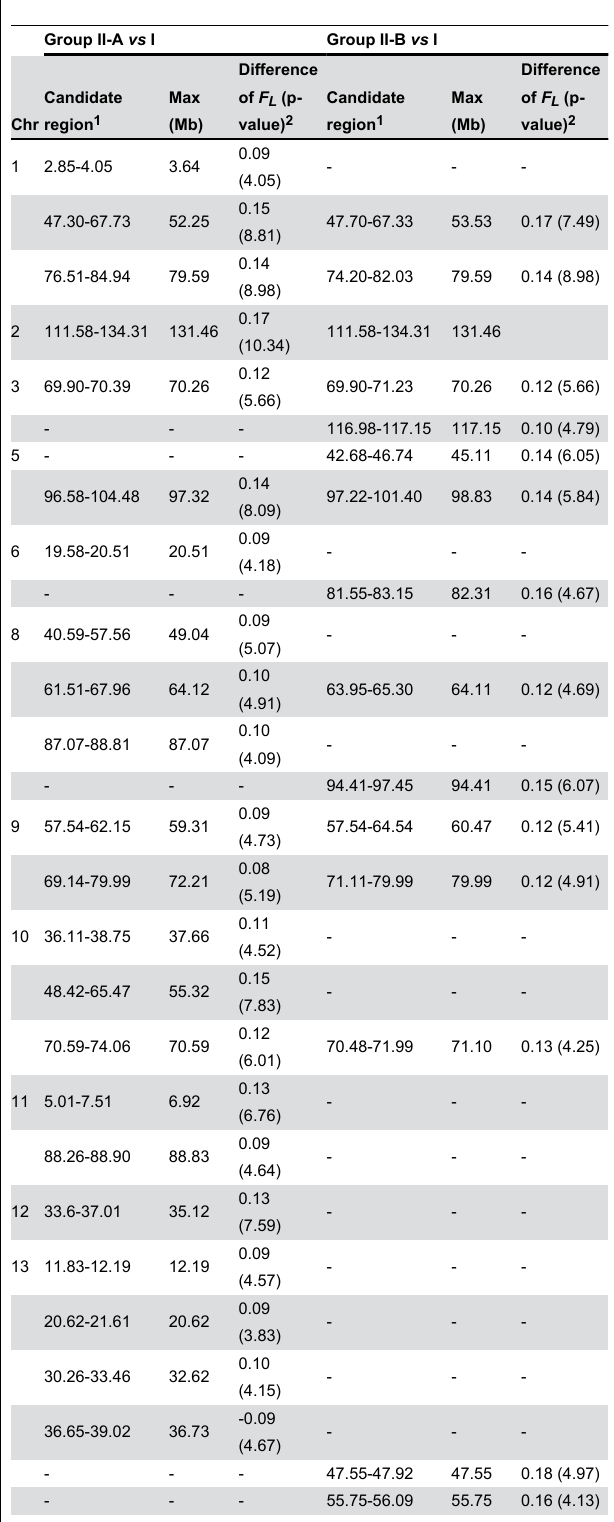
Table 2. Difference of ROH ( F unselected